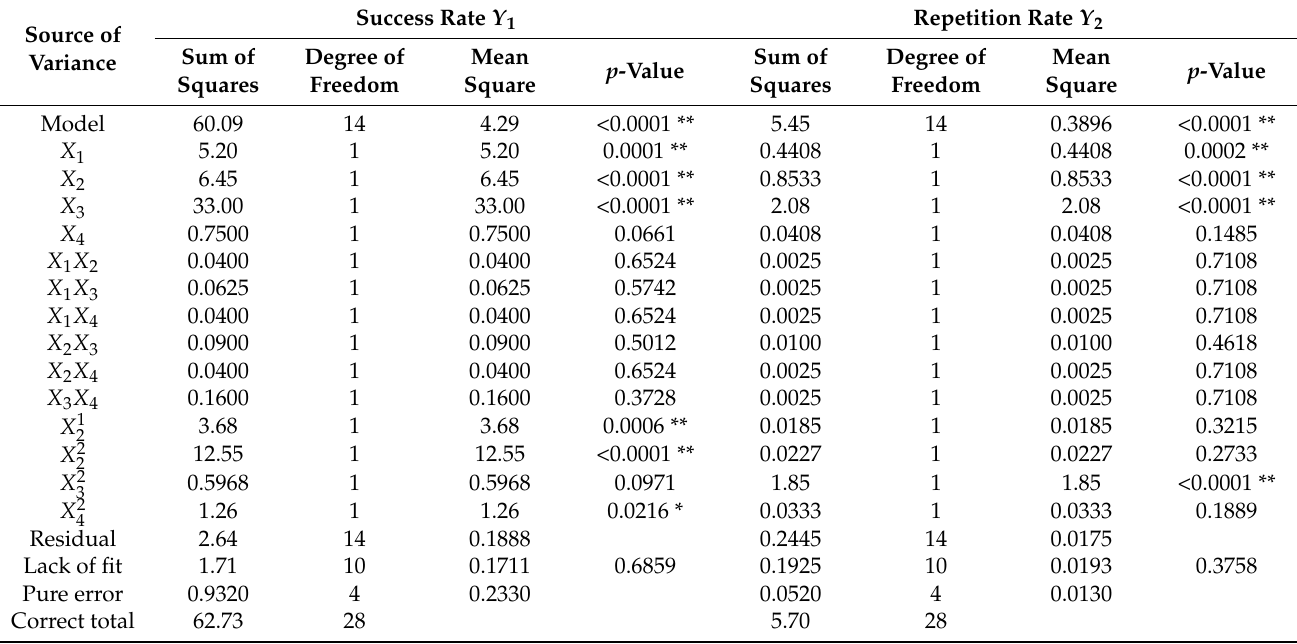
Table 2. Variance analysis of regression